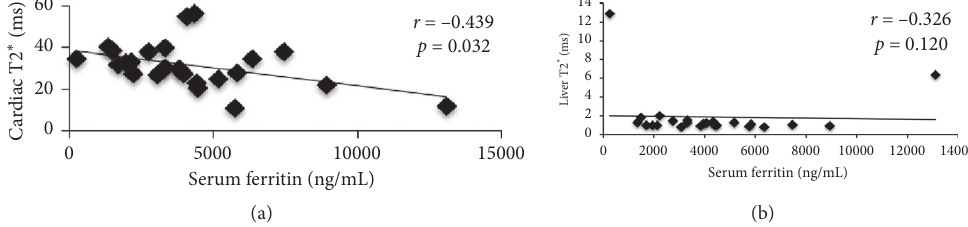
Figure 2: Correlation between serum ferritin and T2 ∗ MRI. (a) Correlation between serum ferritin and cardiac T2 ∗ . (b) Correlation between serum ferritin and liver T2 ∗